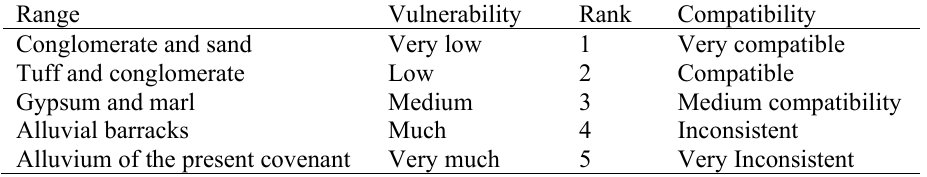
Table 5. Vulnerability ranking of different parts of Tabriz based on type of bedrock Range